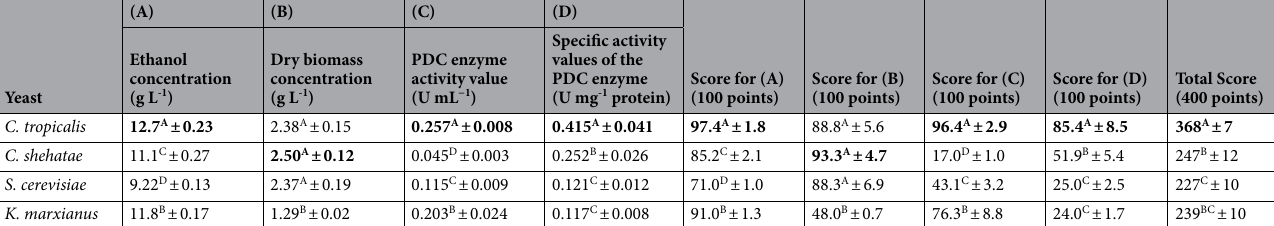
Table 3. Score ranking analysis to select suitable yeast for cultivation. Numbers with the same capital alphabet indicated no significant difference (p > 0.05) for comparison of the same column. Bold data indicated the best average value(s) within each column. PDC: pyruvate decarboxylase. Score ranking was calculated taking account of all the replicates of each criterion in Microsoft Excel spreadsheet. For example: the highest value for raw data of column A (ethanol concentration) was 12.99 g L −1 among all the yeasts (the tabulated value of 12.7 g L −1 was an average value from three raw data which also included the highest value of 12.99 g L −1 ). All other values were then divided by maximum value of 12.99 and multiplied by 100 to get the respective score. Three replicate values of ethanol concentration for S. cerevisiae were 9.10, 9.08 and 9.47 g L −1 . The score is